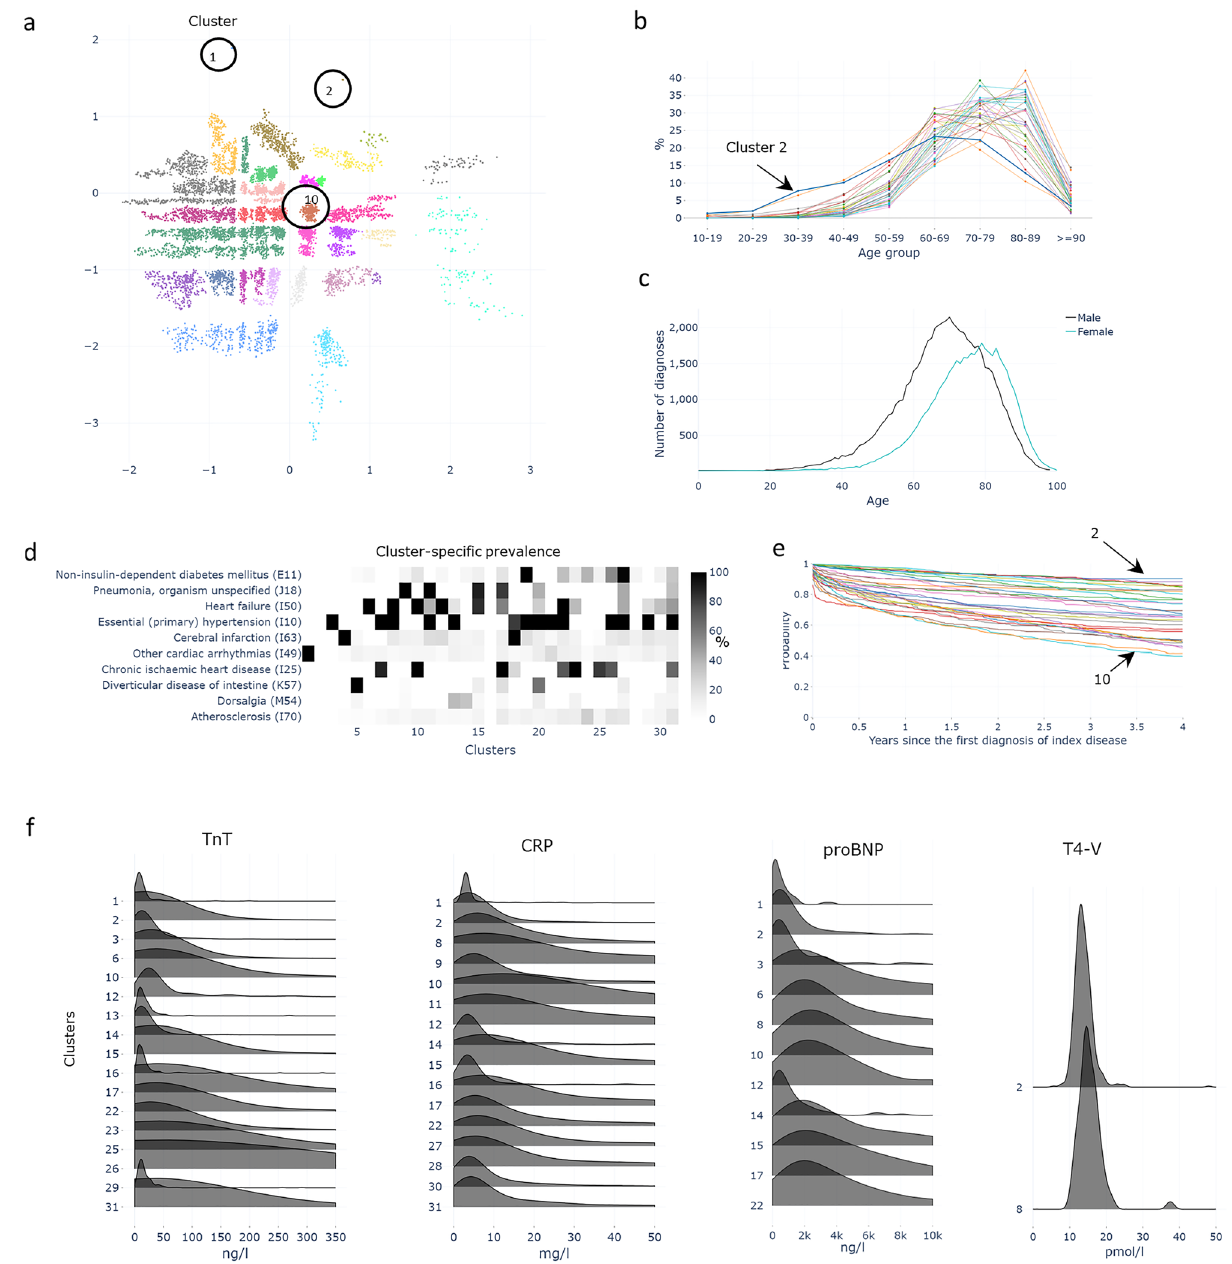
Figure 4. Atrial fibrillation. ( a ) Disease-specific comorbidity clusters represented in two-dimensional latent space of VAE model. ( b ) Age distribution of the clusters, and ( c ) age- and sex distributions of I48 diagnosis among original 1 M patients ( d ) The prevalence of the 10 most frequent diagnoses in comorbidity clusters shown on a heat map. Some diagnoses, e.g. other cardiac arrythmias, diabetes mellitus, and diverticular disease of the intestine, demonstrate cluster specificity, whereas pneumonia, heart failure, hypertension, and ischemic heart disease are more widely distributed across clusters. ( e ) Kaplan–Meier plot showing variation in cluster-specific survival rates. ( f ) Distribution of laboratory measurements of selected tests. Only clusters with statistically significant (FDR 0.1%) results